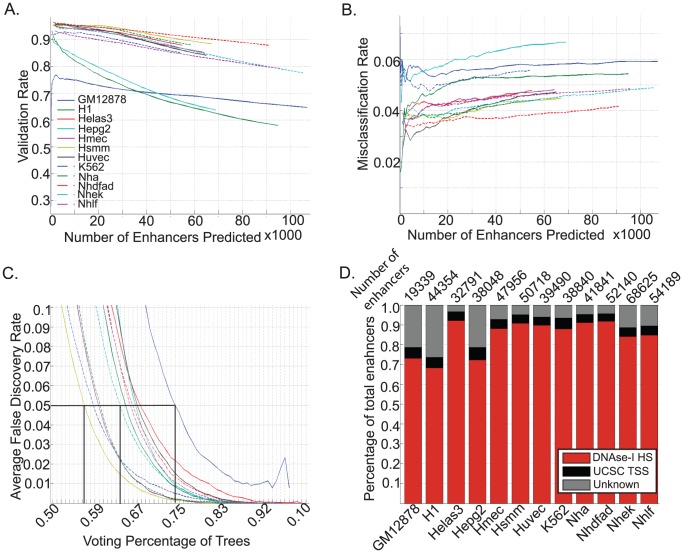
Enhancer predictions in ENCODE cell-lines using RFECS.A.)Validation Rate in the 12 cell-types measured by overlap with DNase-I HS, B.)Misclassification Rate in the cell-types measured as overlap of UCSC TSS, C.)Average false discovery rate (FDR) over the 22 autosomal chromosomes for each cell-type plotted as a function of voting percentage of trees, D.)Validation rate and misclassification rate for each cell-type at a FDR of 5% with number of enhancer predictions shown above the bar.